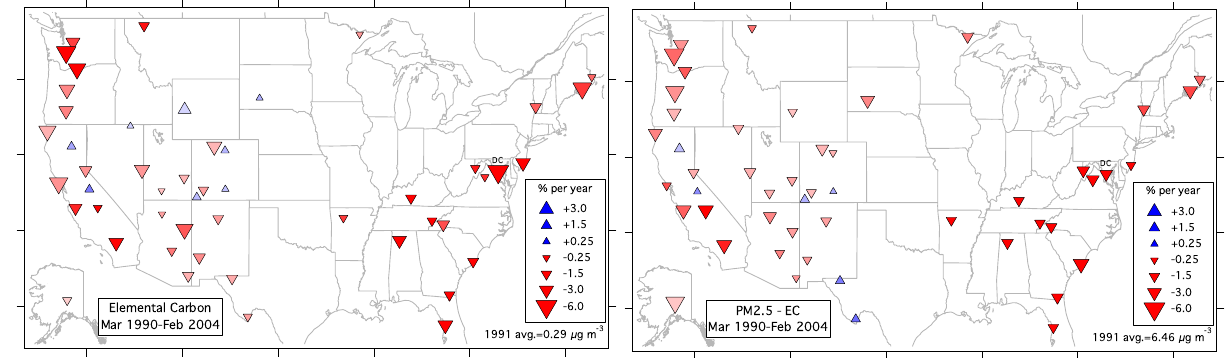
Fig. 2. Trends in EC and PM 2 . 5 (fine particle) mass other than EC at all IMPROVE network stations with sufficient data between 1 March 1990, and 29 February 2004. Marker size indicates the magnitude of the trend. Triangle direction and blue or red color corre- sponds to the sign of the trend. Color saturation is proportional to the average concentration in 1991 with full saturation at twice the national median. The only urban site in Washington DC is marked. Averages in the bottom right corner exclude Washington DC.